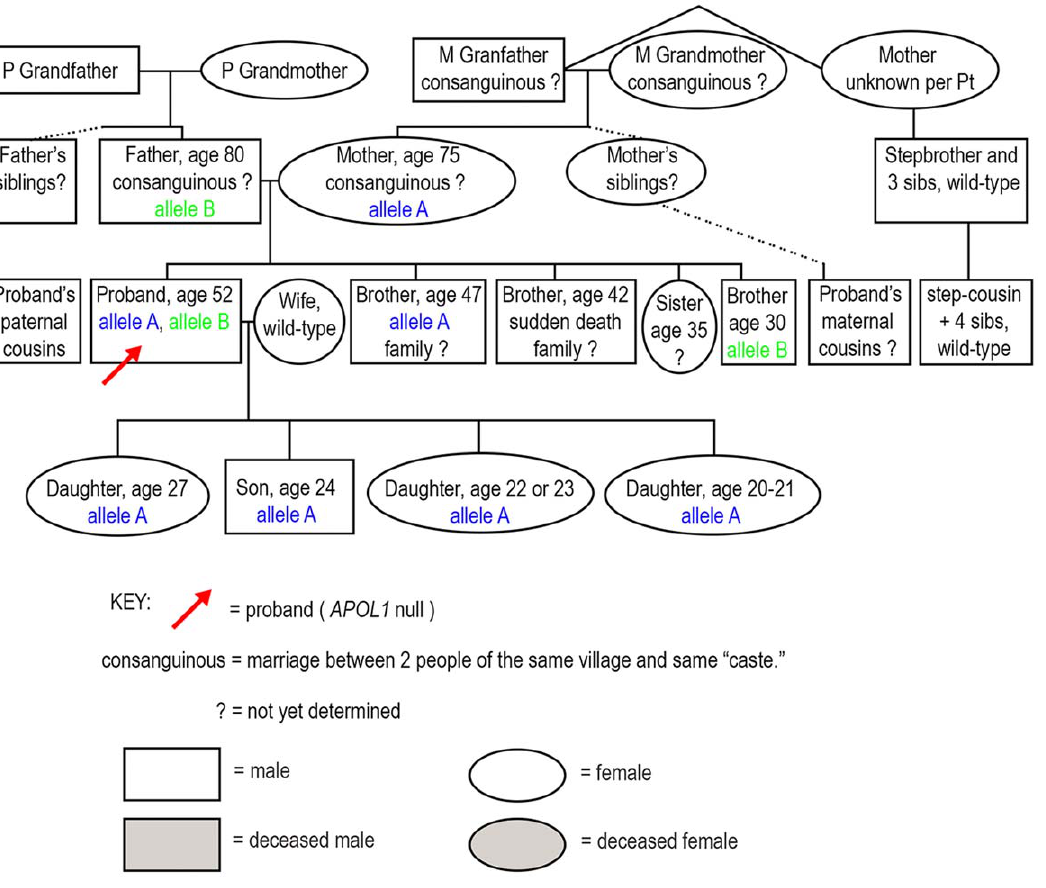
Figure 3. The inheritance of alleles A and B are depicted within a family dendogram, which also illustrates salient clinical findings. Other study participants not depicted in this dendogram were wild type for both APOL1 null alleles and were not part of the immediate family.